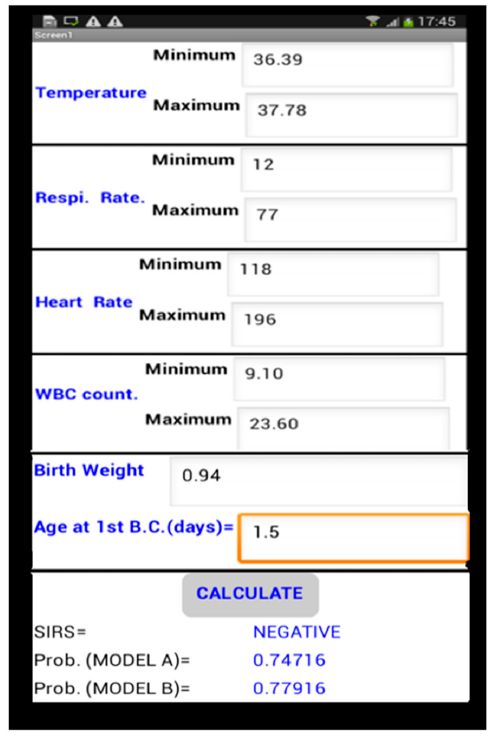
Figure 2. Screenshot of mobile application.